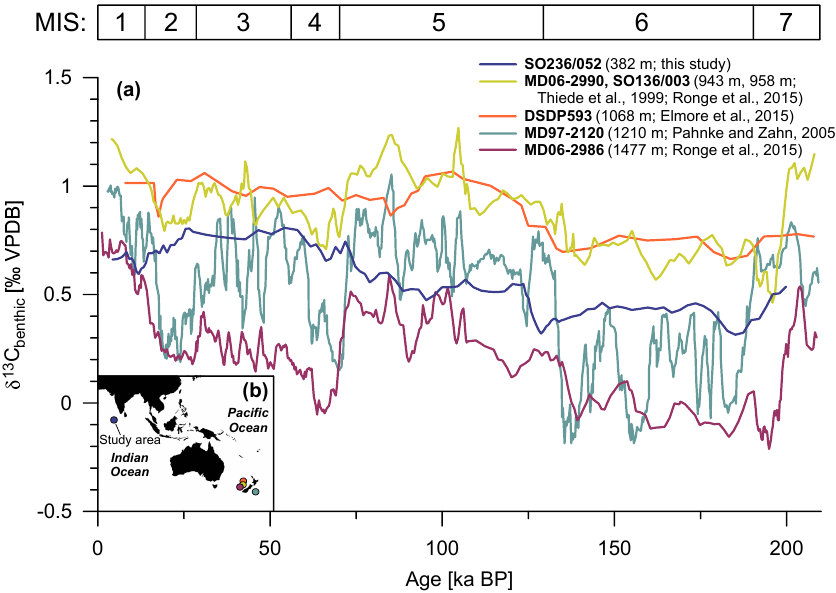
Figure 10. Comparison of epibenthic δ 13 C records from intermediate water depth in the equatorial Indian and temperate south-western Pacific oceans; (a) δ 13 C record of C. mabahethi (blue) from the Maldives Inner Sea (SO236-052) in comparison to δ 13 C records from the south-western Pacific Ocean, which were mainly generated from Cibicidoides wuellerstorfi , C. cicatricosa and C. kullenbergi and represent different water depths (Thiede et al., 1999; Pahnke and Zahn, 2005; Elmore et al., 2015; Ronge et al., 2015). Data of MD97-2120 were traced after Pahnke and Zahn (2005). All lines represent 5-point running averages. (b) Simplified map of the Indian Ocean and the south-western Pacific Ocean with the location of the study